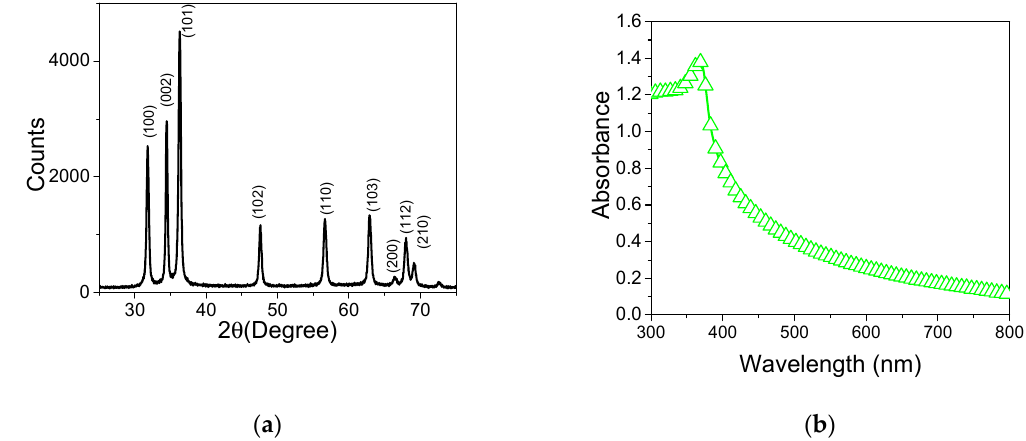
Figure 2. ( a ) XRD diffractograms of ZnO nanorod film and ( b ) absorption spectra of ZnO nanorod film.